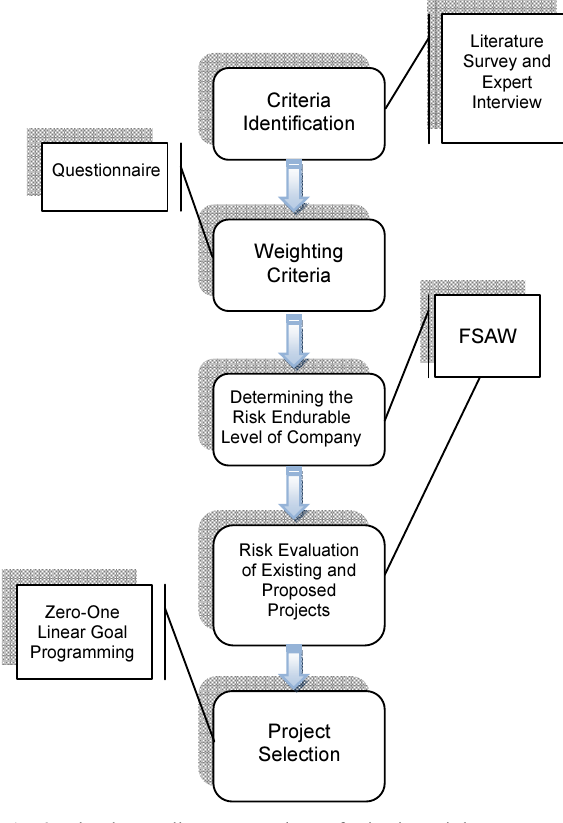
Fig. 2. The descending Pareto chart of criteria weight